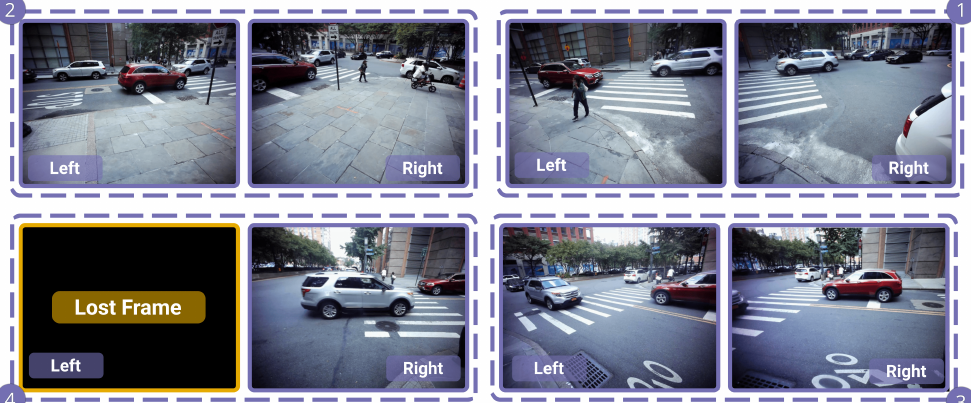
Figure 10. Mosaic rendering of the synchronized frames from recording session one at the Chase Center intersection that can be played as a video. Four sensors with two cameras each (numbered in the corners) provide eight different views for comprehensive analysis of the intersection. If a camera did not successfully record during a particular frame, its block is turned black, such as the left camera of sensor 4 in this